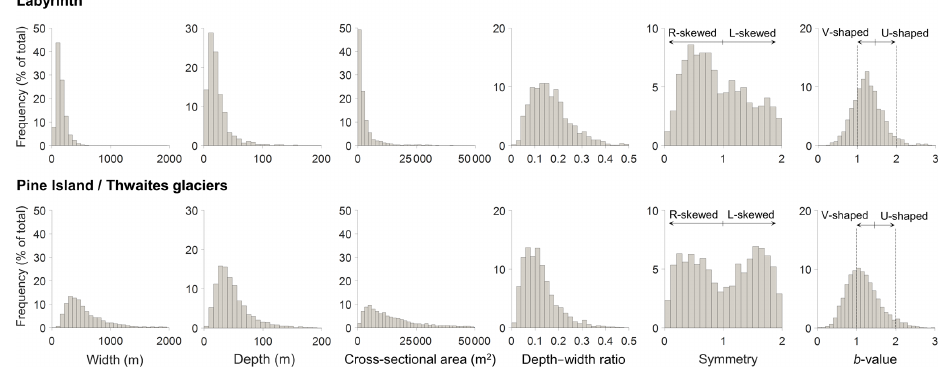
Figure 4. Size–frequency distributions of the morphometric characteristics of the channels comprising the Labyrinth and those present offshore of Pine Island and Thwaites glaciers. The channels offshore of Pine Island and Thwaites glaciers from which the distributions in the lower panel are derived are displayed in Fig. 3. The dotted lines in the b -value plots correspond to where idealized V-shaped ( b = 1) and U-shaped ( b = 2) cross sections would fall on the